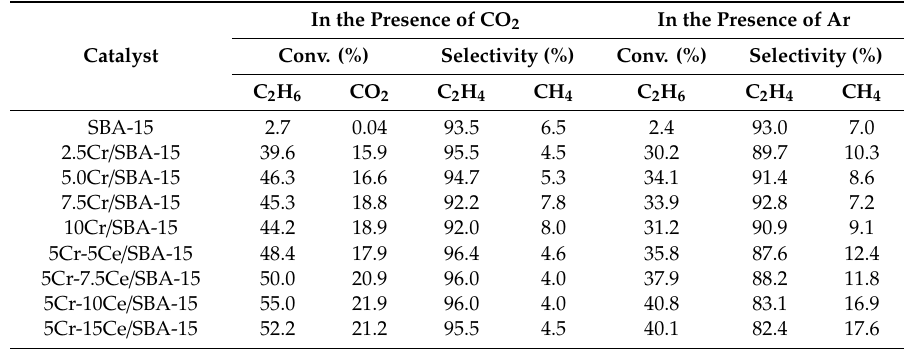
Table 8. Catalytic activity for the dehydrogenation of ethane (Reproduced from [73]; copyright (2008), Springer (Berlin, Germany)).